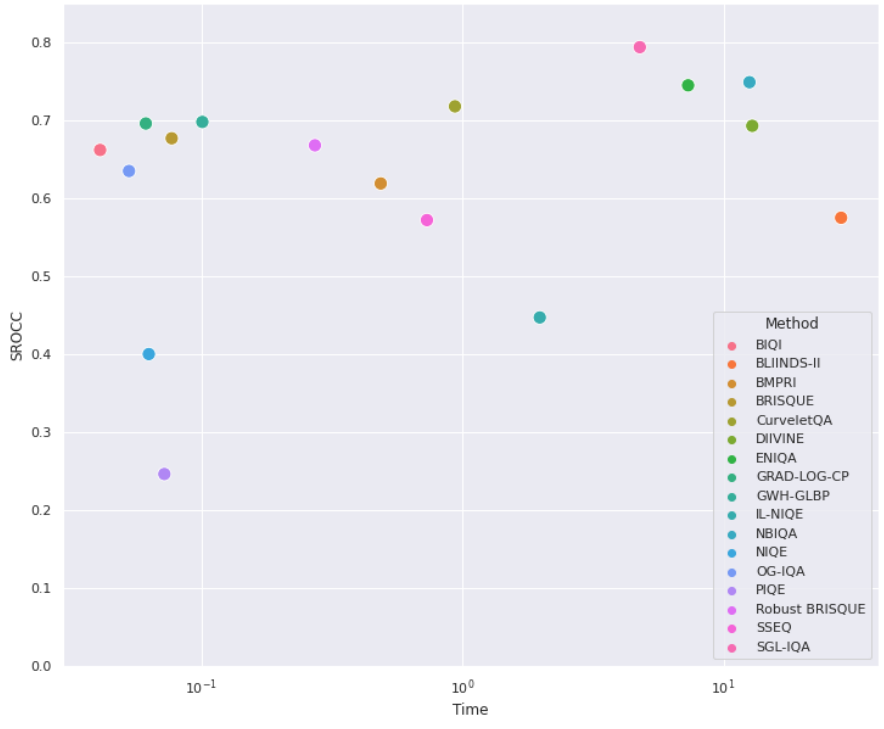
Figure 9. SROCC vs. feature extraction time (given in seconds on a logarithmic scale) based on the results obtained on KonIQ-10k